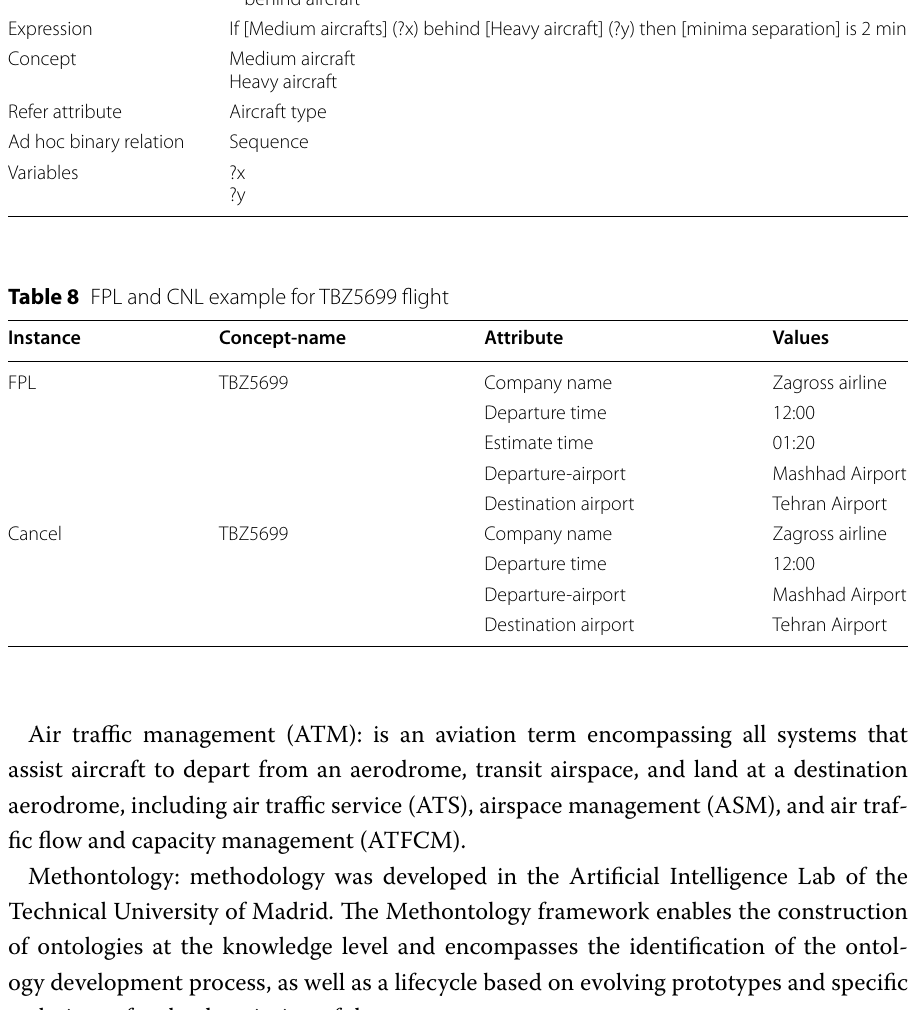
Table 7 Applied rules Rule name Separation for arrival aircraft Description